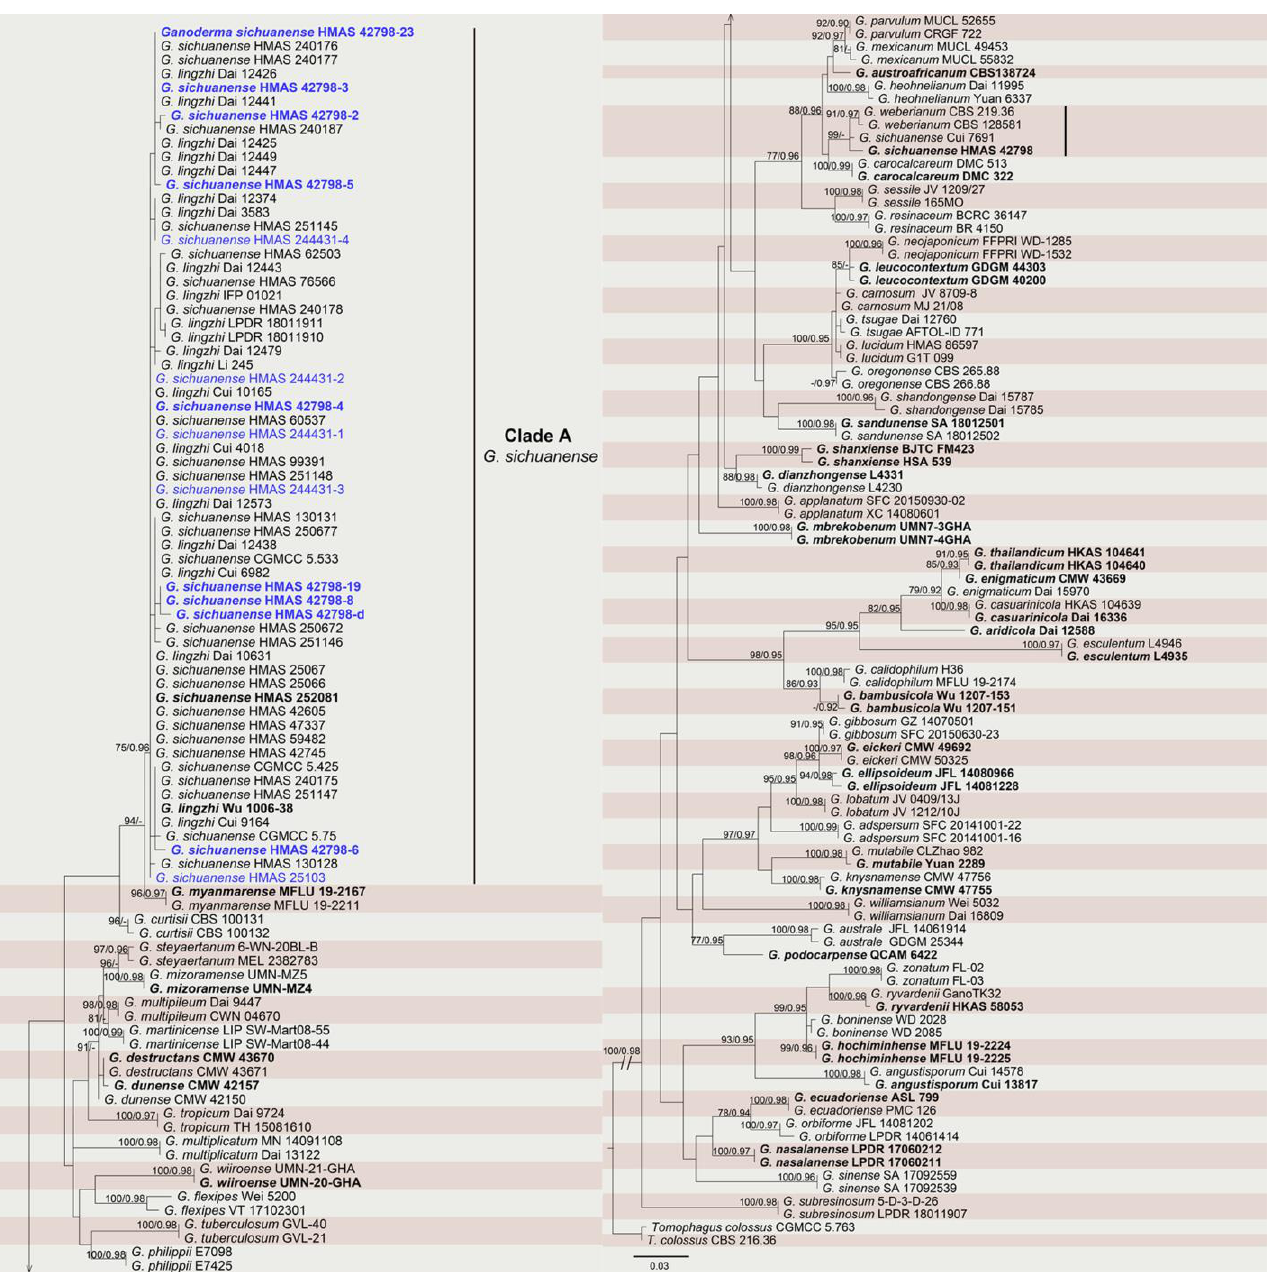
Figure 3. Phylogram of Ganoderma resulting from a maximum likelihood analysis based on the ITS gene. Numbers above the branches indicate ML bootstrap values (left, ML BS ≥ 75%) and Bayesian Posterior Probabilities (right, BPP ≥ 0.90). The tree is rooted with Tomophagus colossus . Sequences from the present study are marked in blue; type materials are bold.